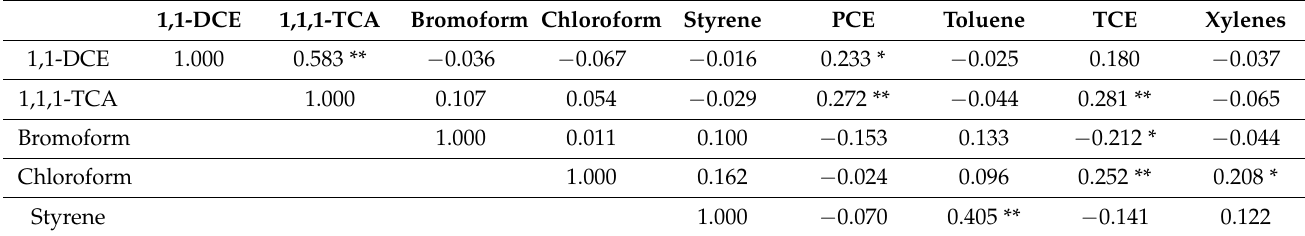
Table 2. Spearman’s correlation coefficients between the detected VOCs ( n =